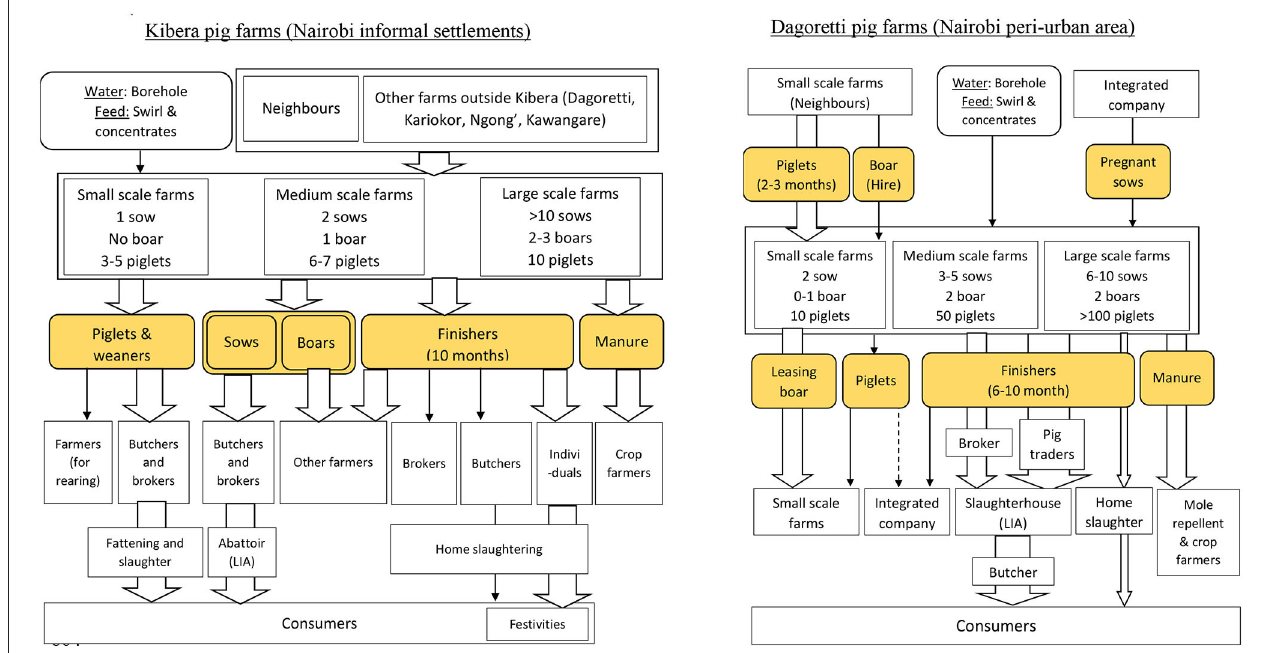
FIGURE 1 | Kibera (left) and Dagoretti (right) farmers profile – The flowchart shows sources and movements of pigs and the types of people involved. Notes: Categories of farm size appear as defined by the focus group discussion participants. Oval shapes colored yellow indicates commodities traded; arrows indicate the flows of products. The arrow width indicates proportional importance in terms of